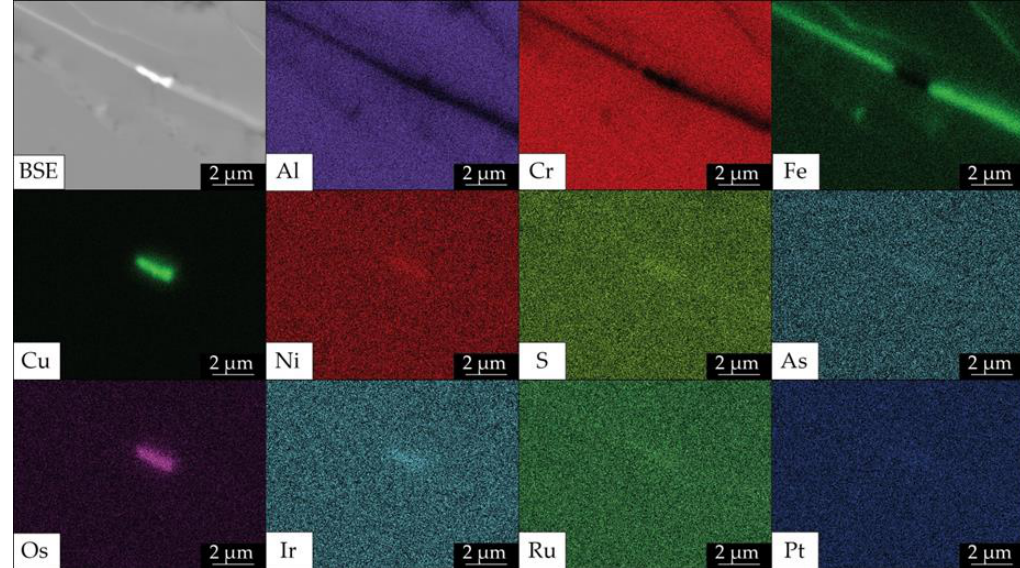
Figure 8. SEM-BSE showing the distribution of Al, Cr, Fe, Cu, Ni, S, As, Os, Ir, Ru, Ptin chromian spinels. The Fe-veins include the Cu-Os phases.